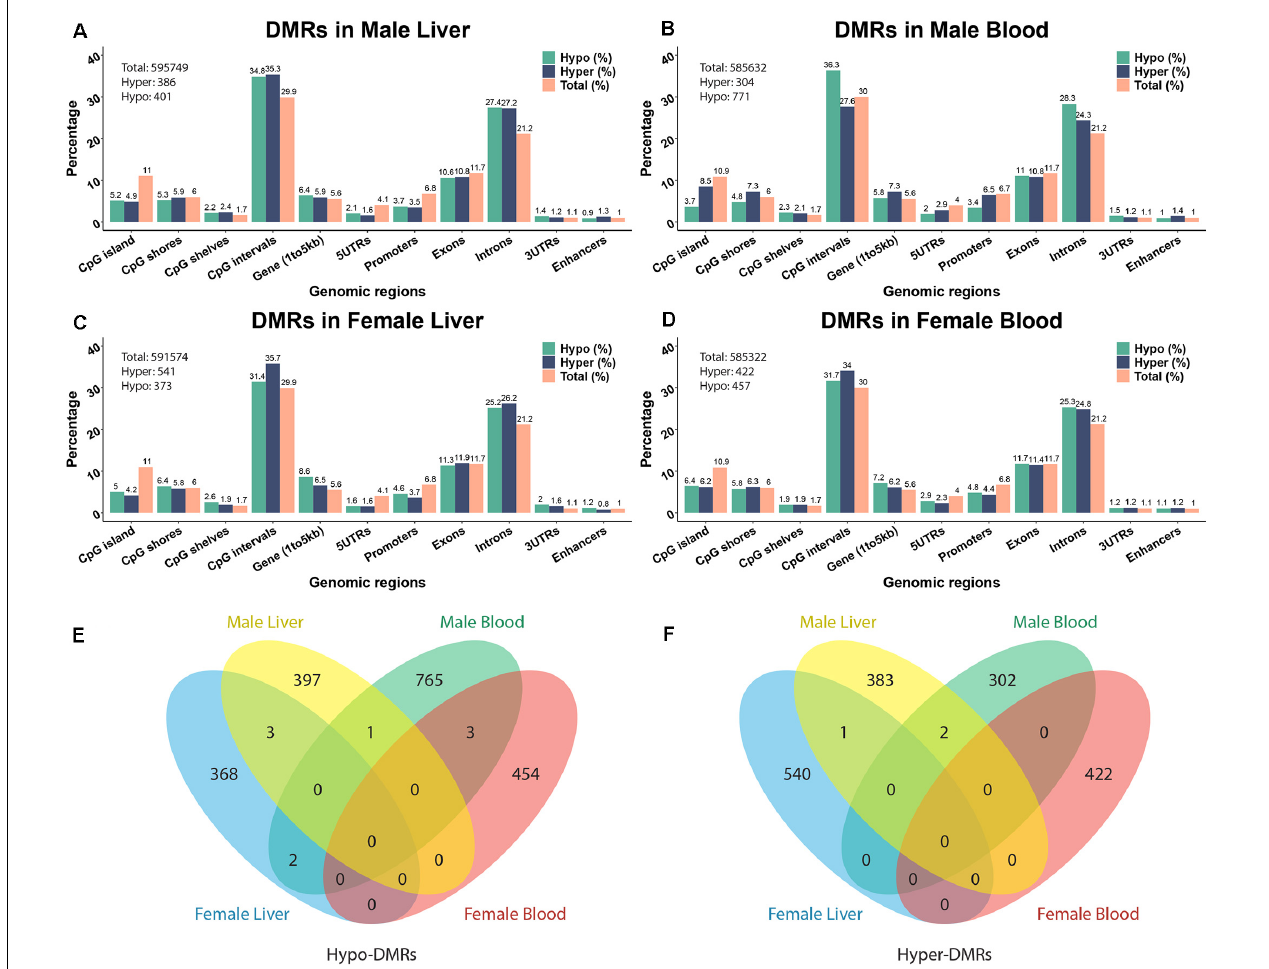
FIGURE 1 | The annotation of Pb-associated differentially methylated regions (DMRs) and related genes. (A–D) depict DMR annotations of male liver, male blood, female liver, and female blood. (E,F) Venn diagram showing the overlapping of hypo- and hyper-DMRs from different tissues in two sexes. The DNA methylation changes are expressed as lead vs